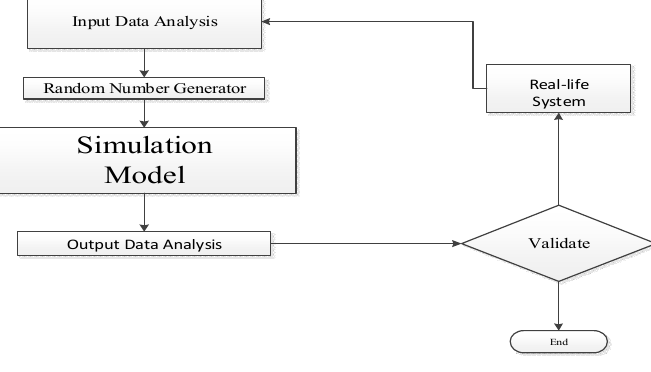
Fig. 3. Simulation